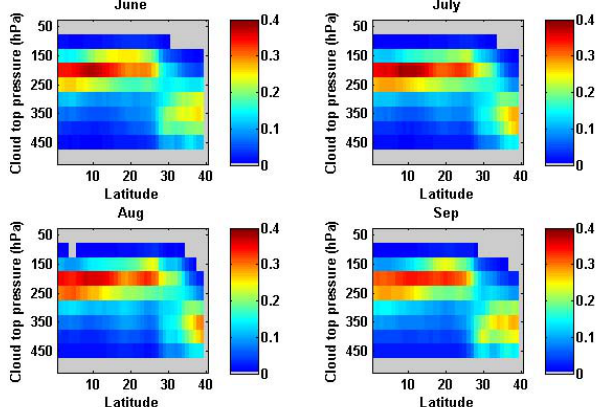
Fig. 8. The latitudinal structure (zonal mean 60E–100E) of cloud top pressure occurrence frequency from MODIS. Each latitude bin is normalized by the total number of cloudy observations in that bin (i.e. the cumulative distribution with height is 1 for each latitude